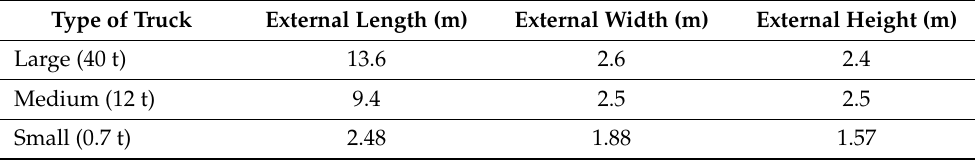
Table 5. Size of different types of trucks used for modeling. Reprinted with permission from ref. [55], Copyright